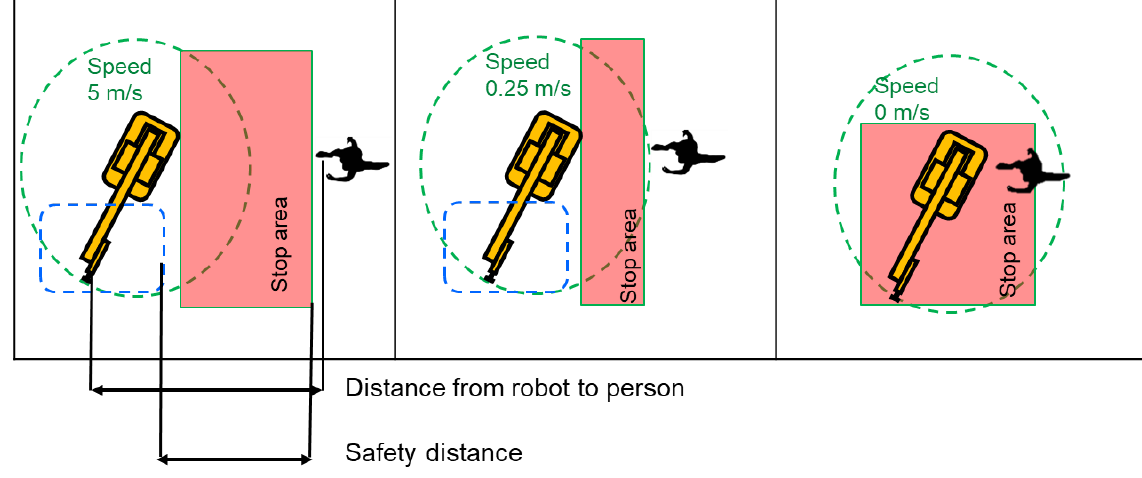
Figure 4: Relation between speed and stop area. As a person gets closer to the robot, the speed and stop area are reduced and at the right robot is stopped and stopping is monitored. Safety distance is defined on the